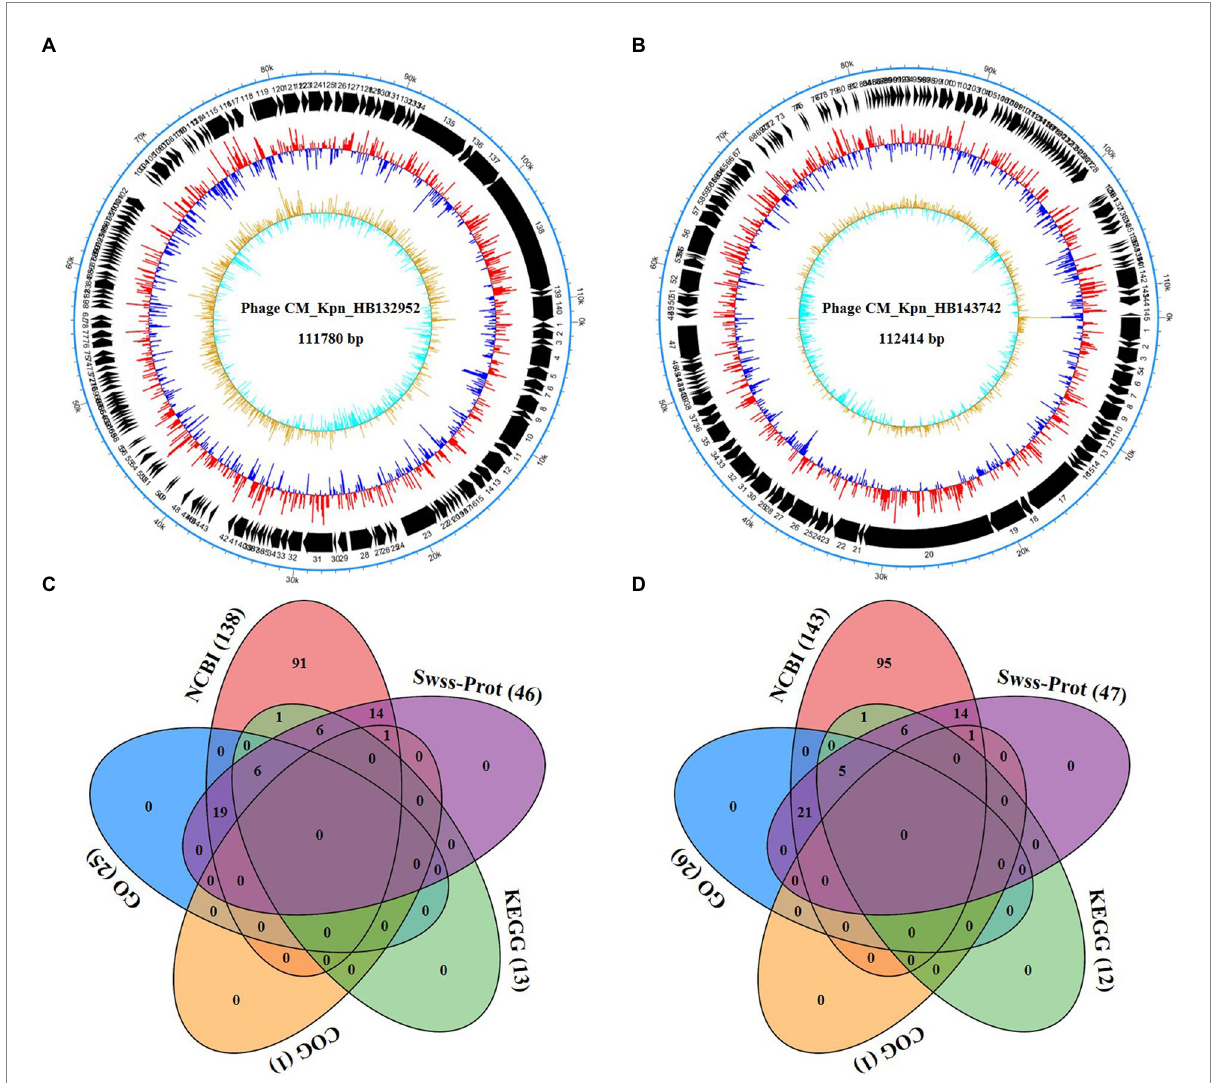
FIGURE 4 Whole-genome analyses of phages. (A,B) The genome structure of phage CM_Kpn_HB132952 and CM_Kpn_HB143742, respectively. (C,D) Predicted gene annotation numbers in NCBI, Swiss-Prot, GO, COG, and KEGG databases of phage CM_Kpn_HB132952 and CM_Kpn_HB143742,